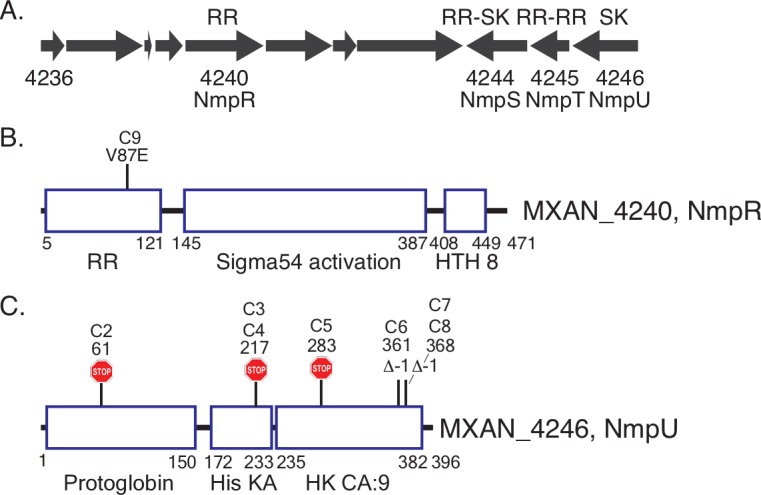
Suppressor mutations identified in uncharacterized TCS signaling genes.Suppressor strains were sequenced with the Illumina MiSeq platform and compared to the annotated M. xanthus DK1622 genome [27]. (A) Genomic organization of the locus containing the RR gene mxan_4240 (nmpR) (B) and SK gene mxan_4246 (nmpU) (C). This locus also contains a gene encoding a protein with two RR receiver domains (mxan_4245, nmpT, RR-RR) and an atypical hybrid response regulator/sensor kinase (mxan_4244, nmpS, RR-SK). The results of the mutations are depicted (B and C): a missense mutation in nmpR (V87E) and premature stop codons (stop signs) or frameshifts (Δ-1) in nmpU. The location of the mutations within each protein is to scale. The positions of each domain of these proteins is also indicated by amino acid number (RR = response regulator receiver domain, Sigma54 activation = central ATPase that interacts with σ54, HTH_8 = DNA-binding helix-turn-helix, Protoglobin = putative heme binding sensor domain, HisKA = domain of histidine phosphorylation and SK dimerization, HK CA:9 = ATPase. All domain nomenclatures are based on the Mist 2.2 database [87] and Pfam (http://pfam.xfam.org, [93]). The strain designation (C1-C9) is the same as in Table 1 and Fig 1.